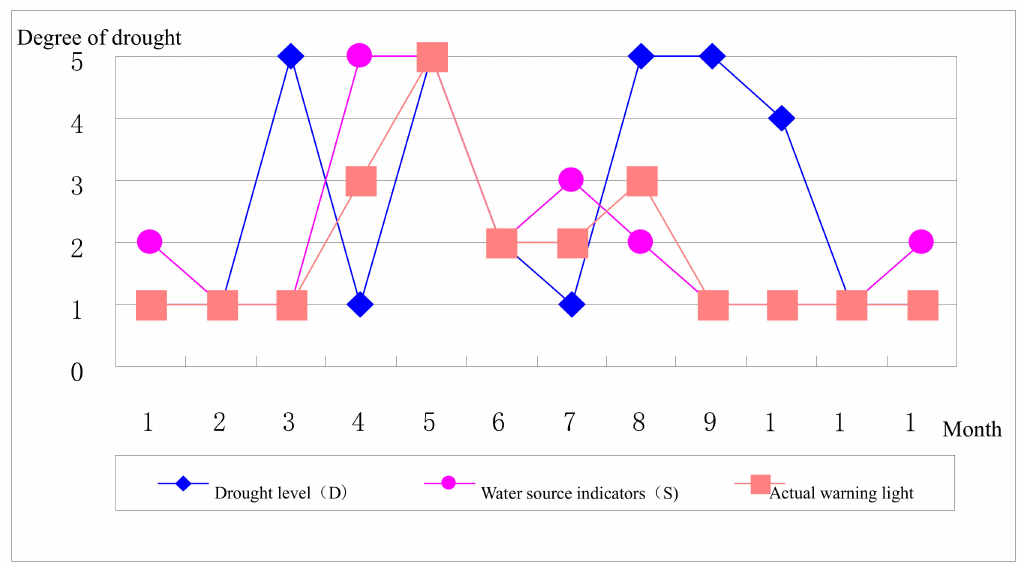
Figure 6. Monthly drought grades and actual early warning signals in